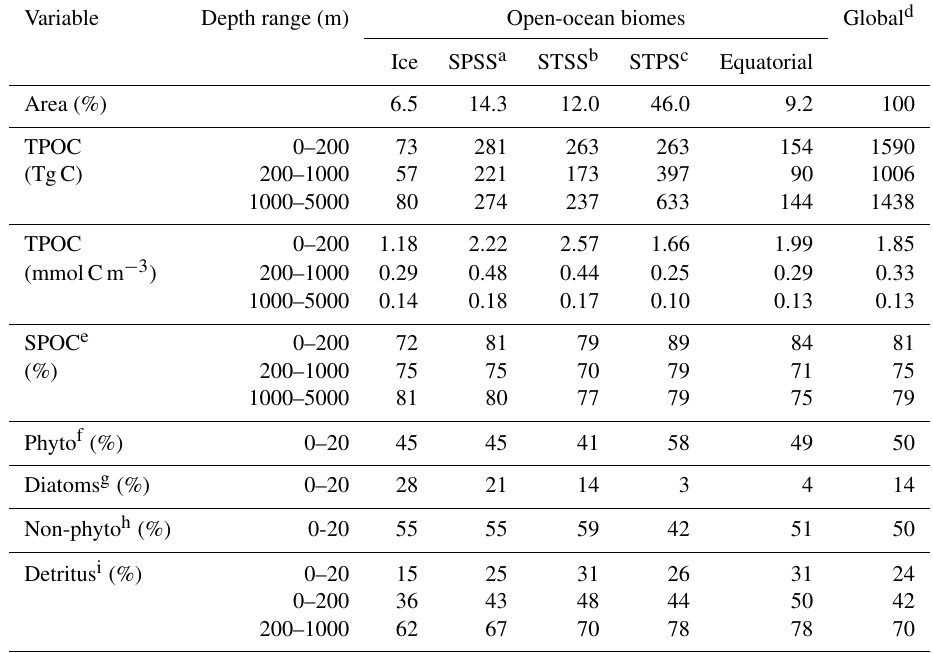
Table 3. Global and regional POC stocks, concentrations, and fractions in different layers as simulated by PISCESv2_RC.